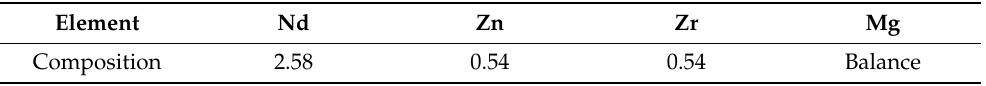
Table 1. The chemical composition of as-extruded Mg-Nd-Zn-Zr alloy (wt%) [11]. Element Nd Zn Zr Mg Composition 2.58 0.54 0.54